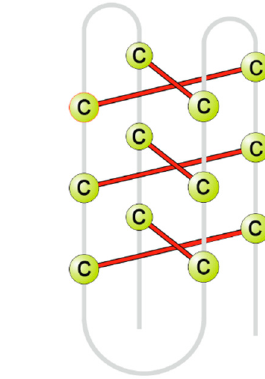
Figure 3. Primary ( left ) and secondary ( right ) structure of i-motif.